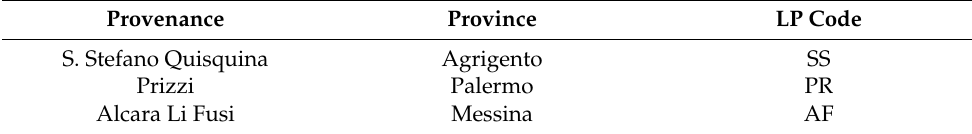
Table 2. Provenance and local Salvia sclarea L. population